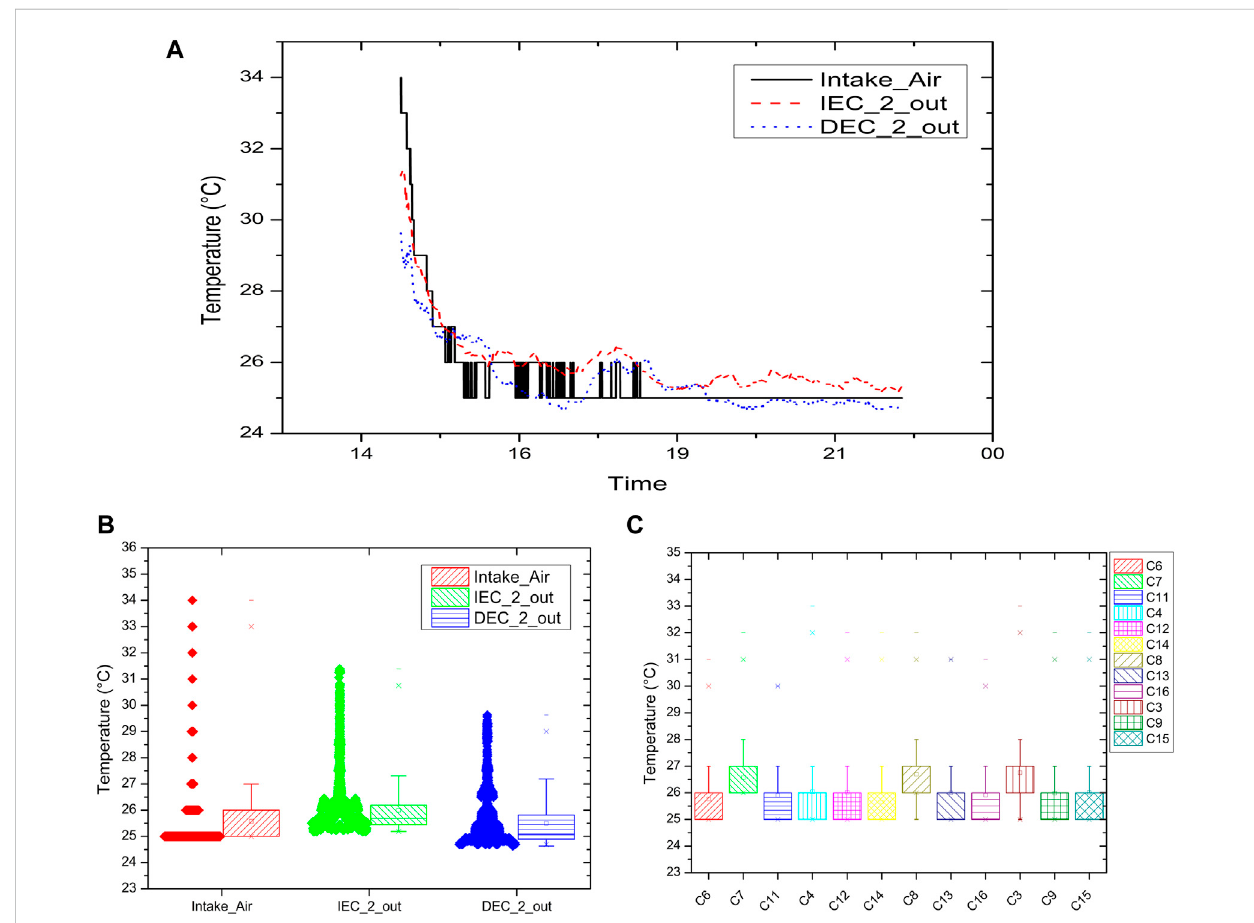
FIGURE 6 Results of real time temperature data recorded from (A) 1500 h until 2211 h, (B) the corresponding Mean value showing respective temperature ranges, and (C) scattering of temperature values recorded in the testing